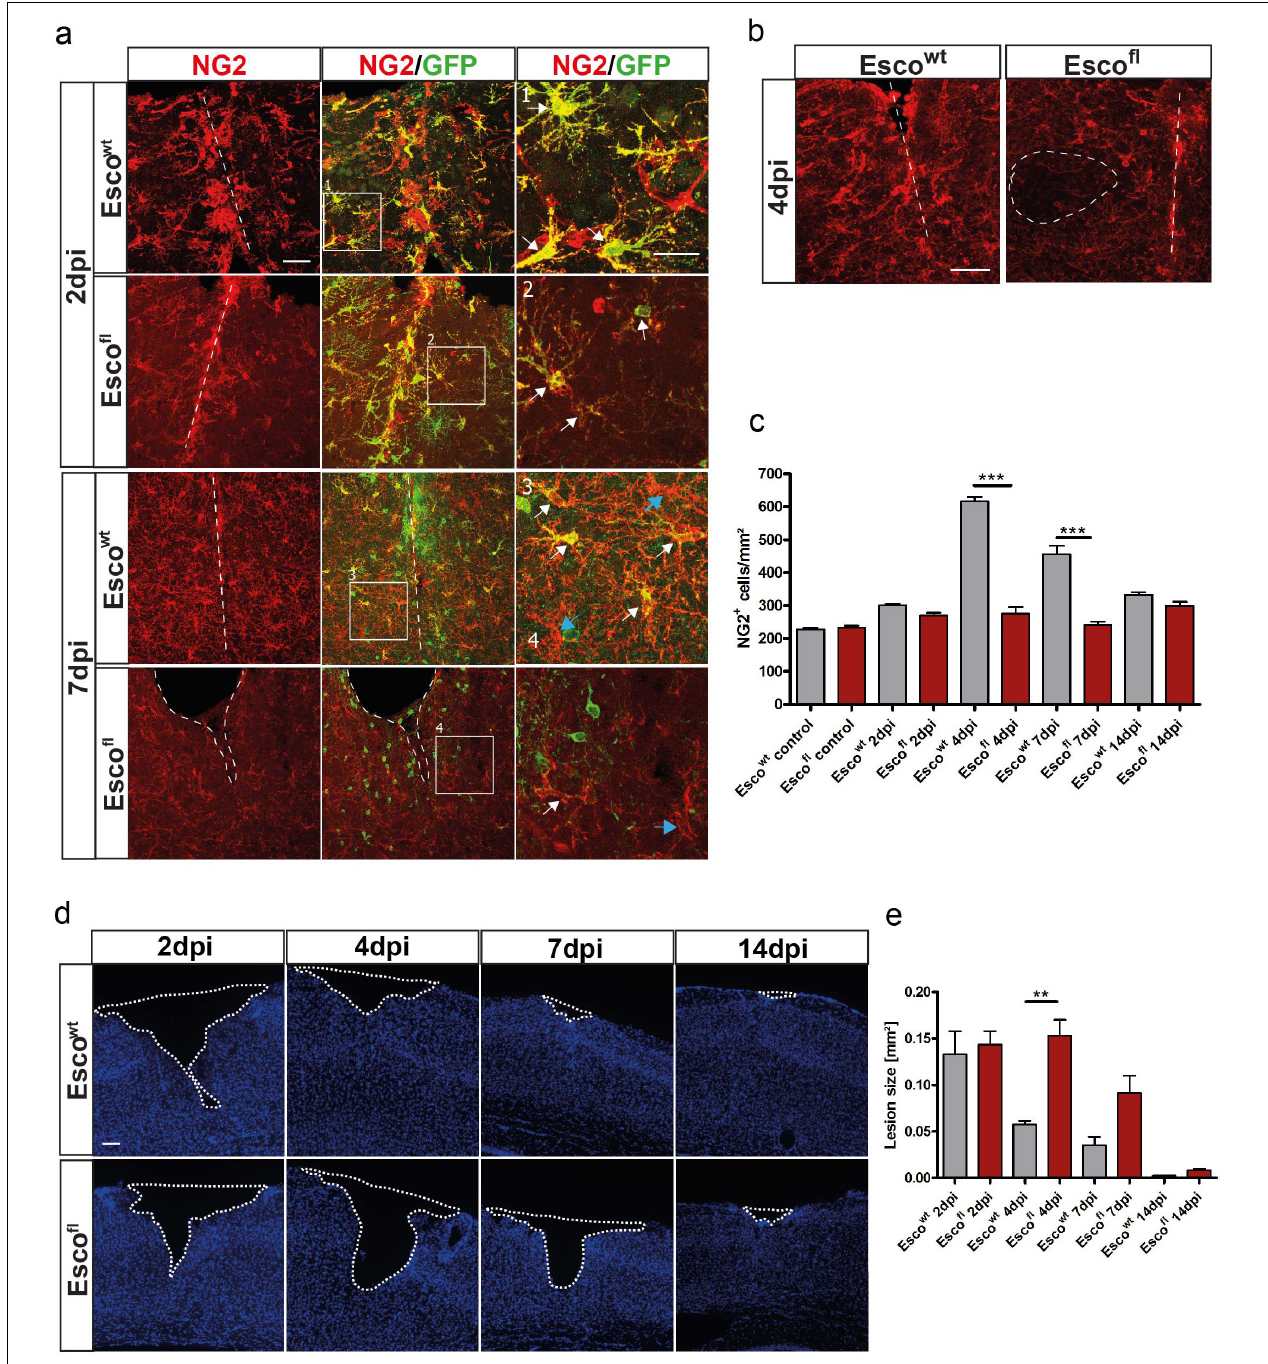
FIGURE 5 | Depletion of NG2-glia after injury leads to impaired wound closure. (a) Confocal images of NG2 + cells in Esco wt and Esco fl animals at 2 and 7 dpi. (b) NG2 + cells in Esco wt and Esco fl animals at 4dpi. In Esco fl animals, areas with complete absence of NG2-glia can be observed (dashed ellipse). (c) Cell counts of NG2 + cells per mm 2 in Esco wt and Esco fl animals in control, non-lesioned brains and at different timepoints after the lesion. Esco fl mice show a reduced cell number after injury (n = 3 animals for each genotype and timepoint, cell counts are presented as mean + SEM; 1way ANOVA with Tukey post-test: ∗∗∗ indicates significance level of p < 0.0001). (d) Lesion size in the cerebral cortex visualized by the lack of DAPI positive cells in Esco wt and Esco fl animals at different timepoints after the lesion. (e) Size of the lesion in mm 2 at 2, 4, 7 and 14dpi in Esco wt and Esco fl animals. Esco fl animals show a significantly bigger lesion compared to Esco wt control littermates. (n = 3 for Esco wt (2, 7 and 14dpi), n = 4 for Esco wt (4 and 14dpi), n = 5 for Esco fl (2dpi), n = 6 for Esco fl (4 and 7dpi) animals), data are presented as mean ± SEM; 1way ANOVA with Tukey post-test: ∗∗ indicates significance level of p < 0.001. Scale bars represent 25 µ m in (a) inlays, 50 µ m in (a) and (b) , 100 µ m.